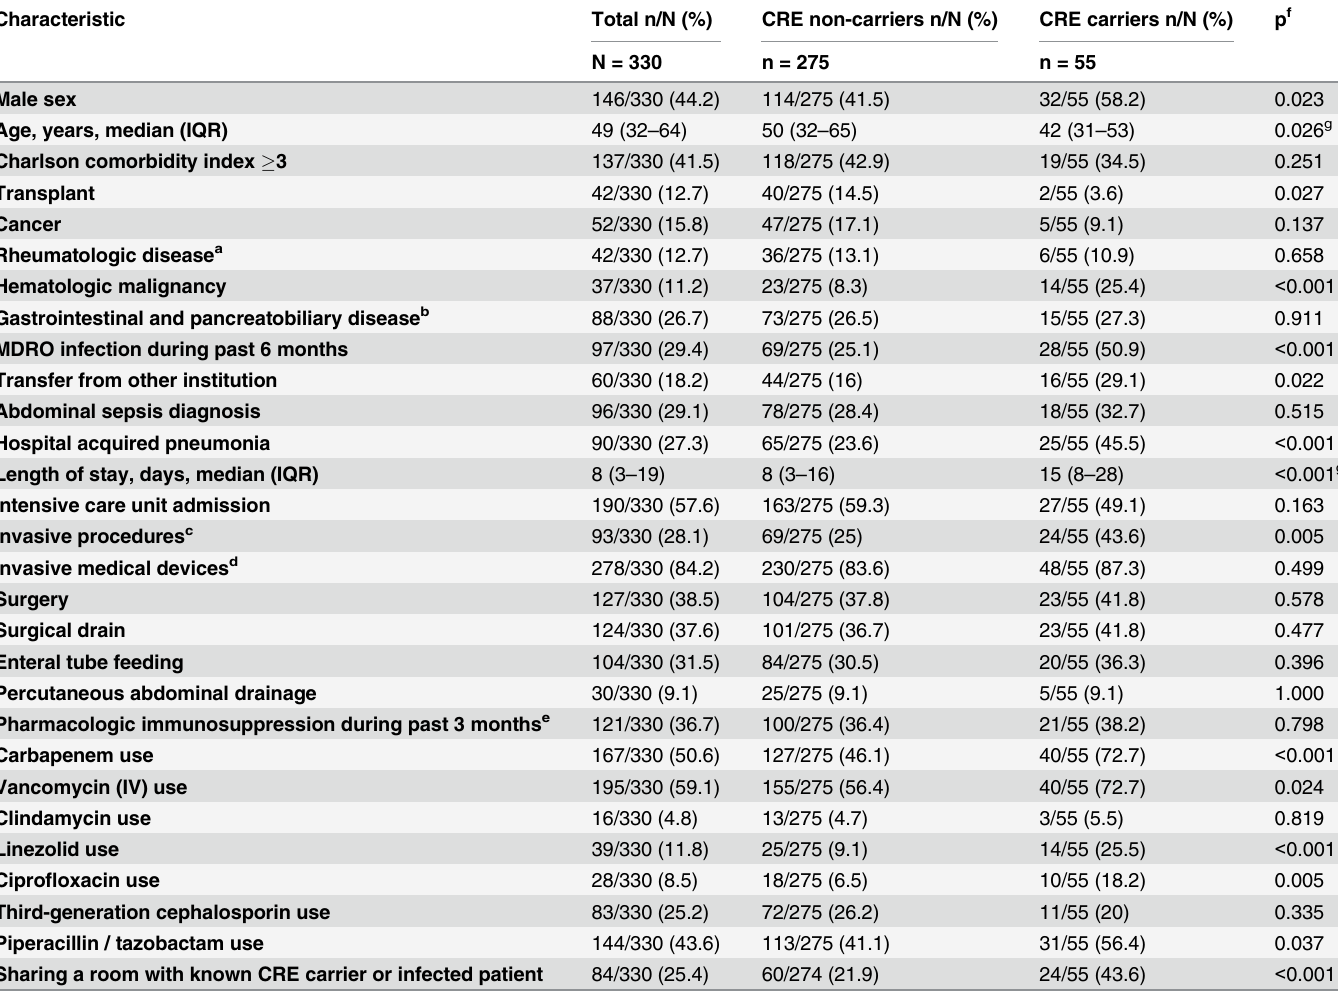
Table 2. Characteristics Associated to Carbapenem-Resistant Enterobacteriaceae Fecal